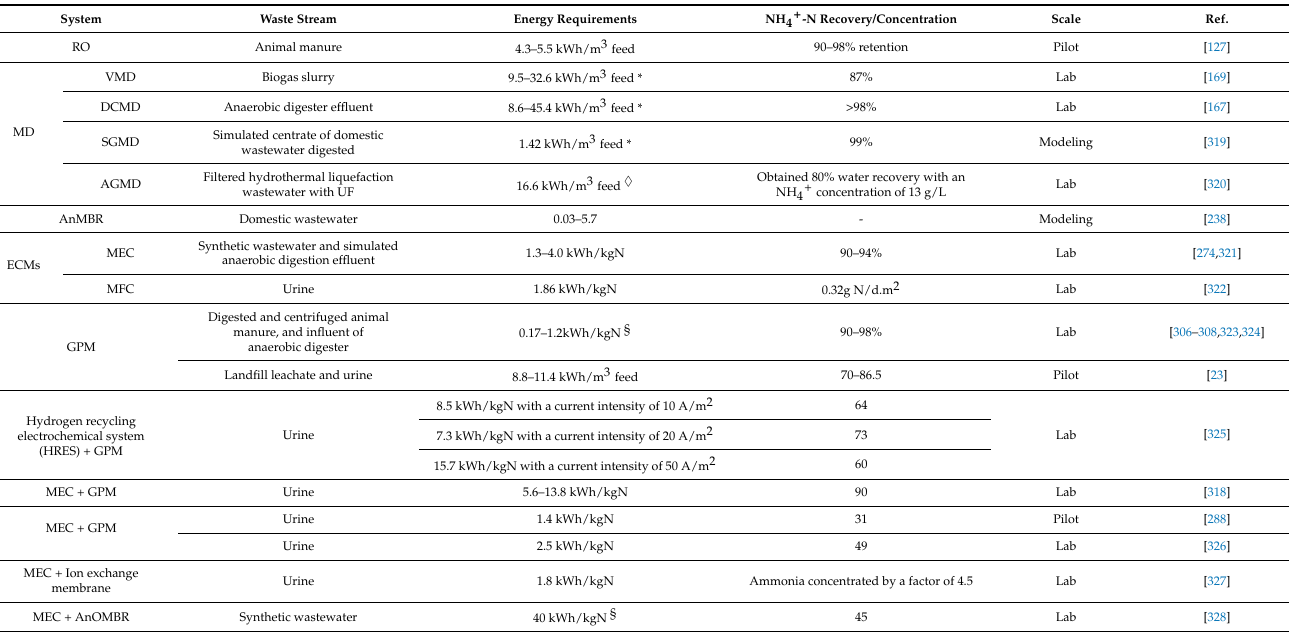
Table 9. Summary of energy requirements and performance of single and hybrid systems from technologies in T2–T4 groups as reported in the